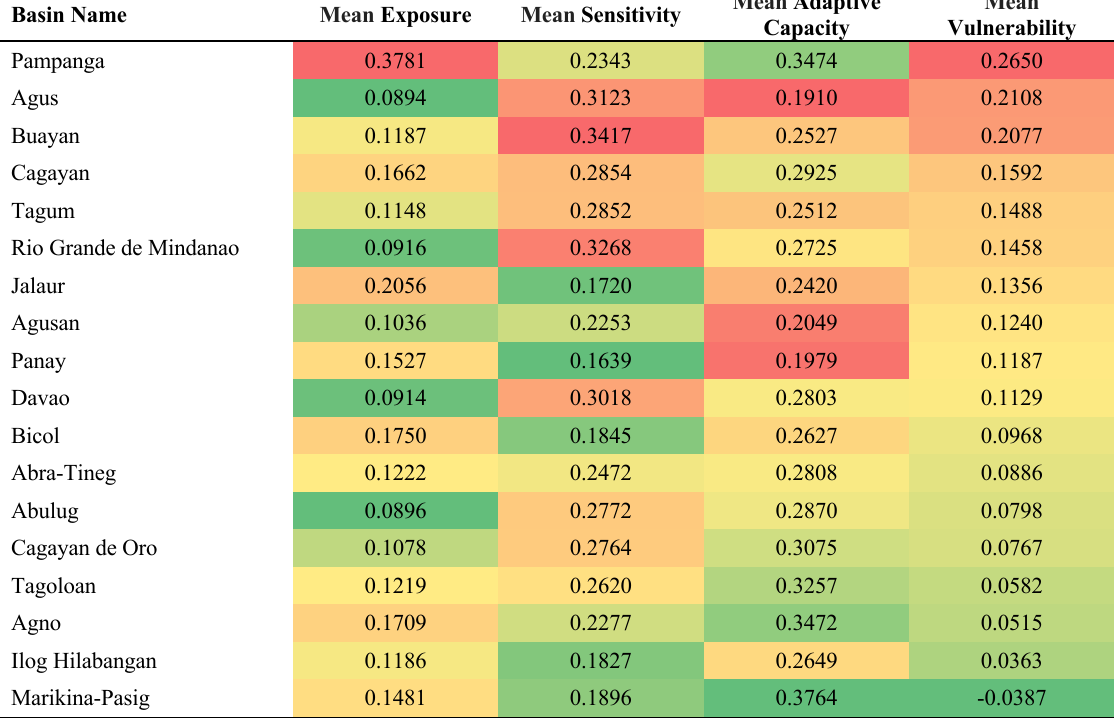
Table 3. The 18 major river basins in the Philippines ranked on the basis of their spatially averaged indices for exposure, sensitivity, adaptive capacity and vulnerability of their agricultural land. The graduated color, from red to green, indicates increasing position of